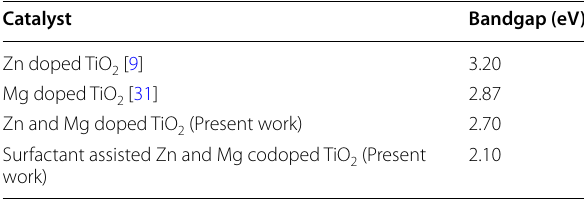
Table 3 Comparative band gap values of Zn and Mg